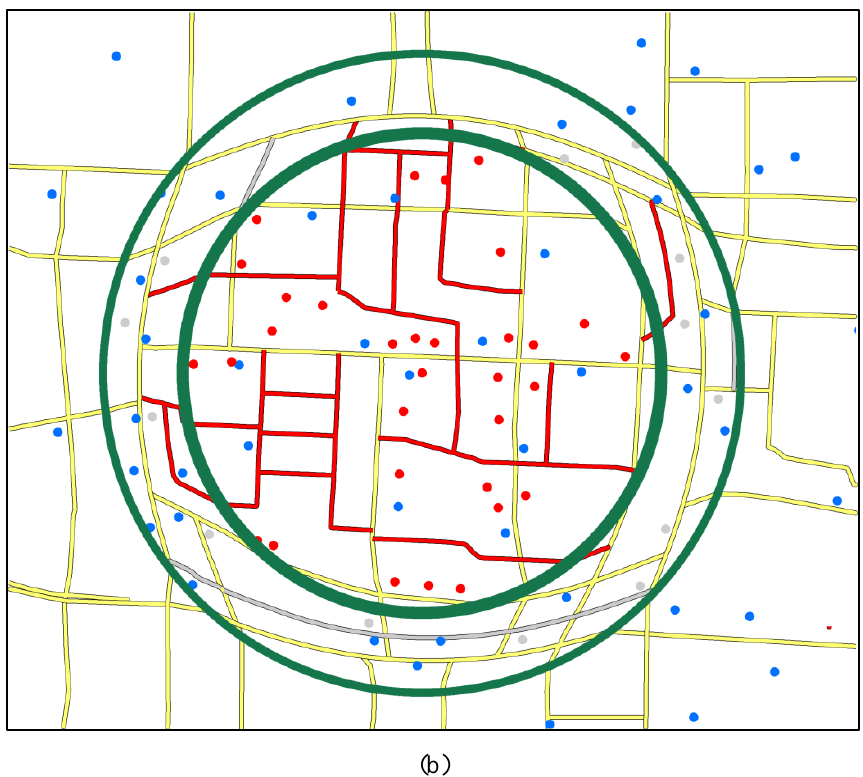
Figure 7. Schematic of the variable-scale representation: ( a ) fixed-scale representation; ( b ) variable-scale representation.